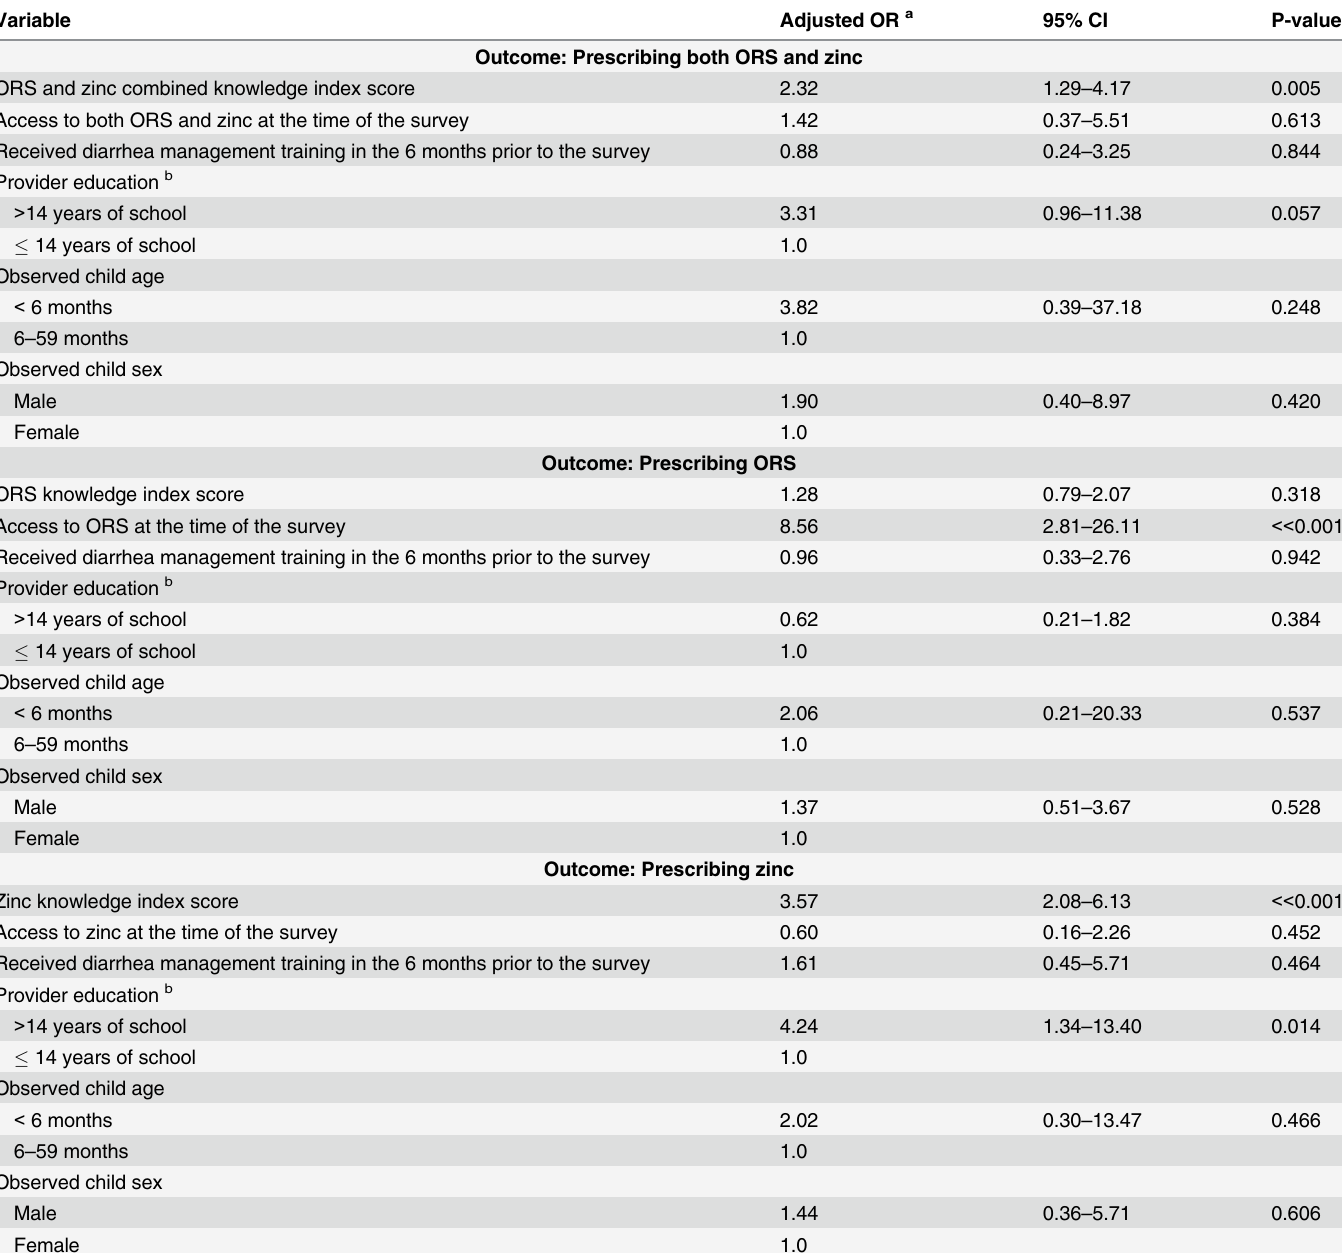
Table 5. Factors associated with prescribing among private sector